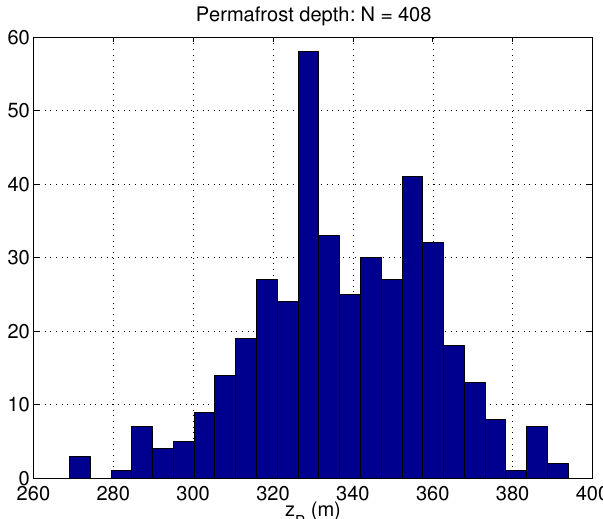
Fig. 11. Histograms of the depth to the lower boundary of per- mafrost for the Monte Carlo simulations in Fig. 10. This depth is defined at a temperature of 0 ◦ C, which is a lower limit for this pa-